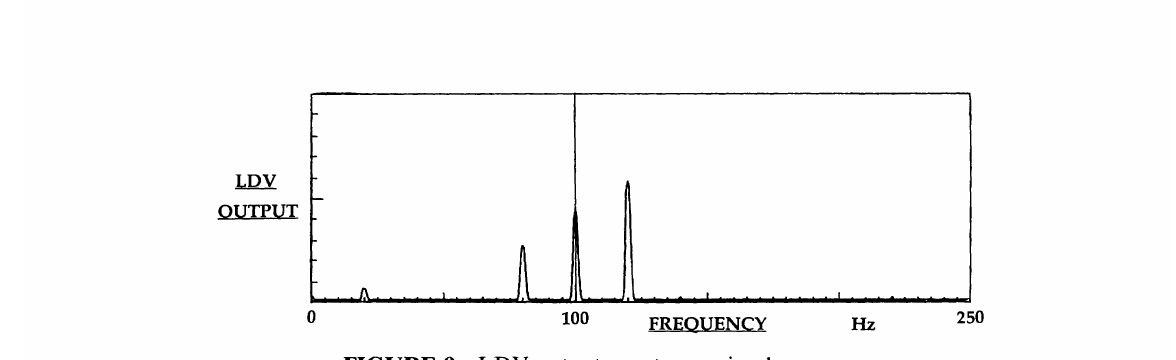
FIGURE 9 LDV output spectrum, circular